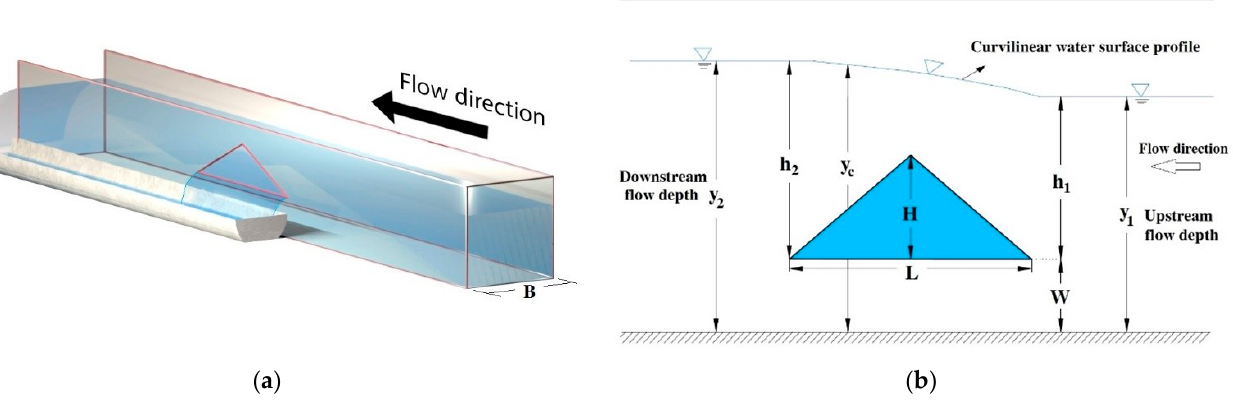
Figure 1. Water surface pro fi le in an equilateral Δ -shaped side ori fi ce located in a horizontal rectan- gular channel under subcritical regime. ( a ) 3D view ( b ) pro fi le view